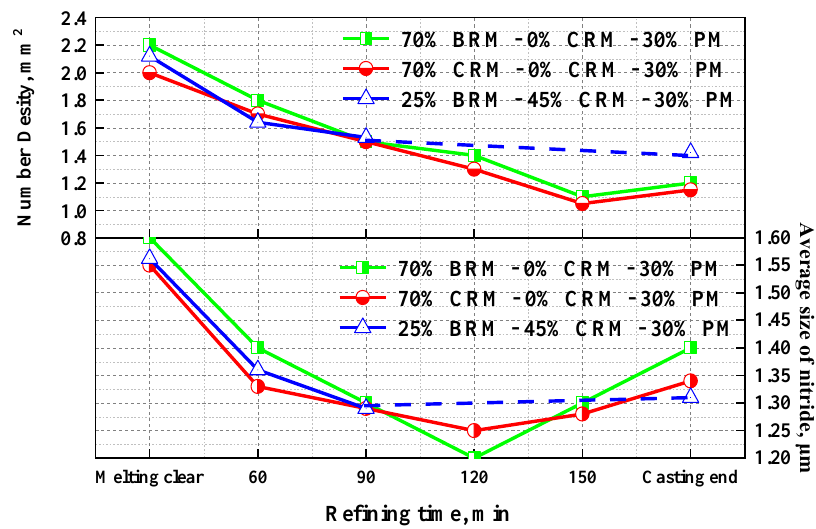
lead to different nitrogen compounds in the initial stage of refining [26].